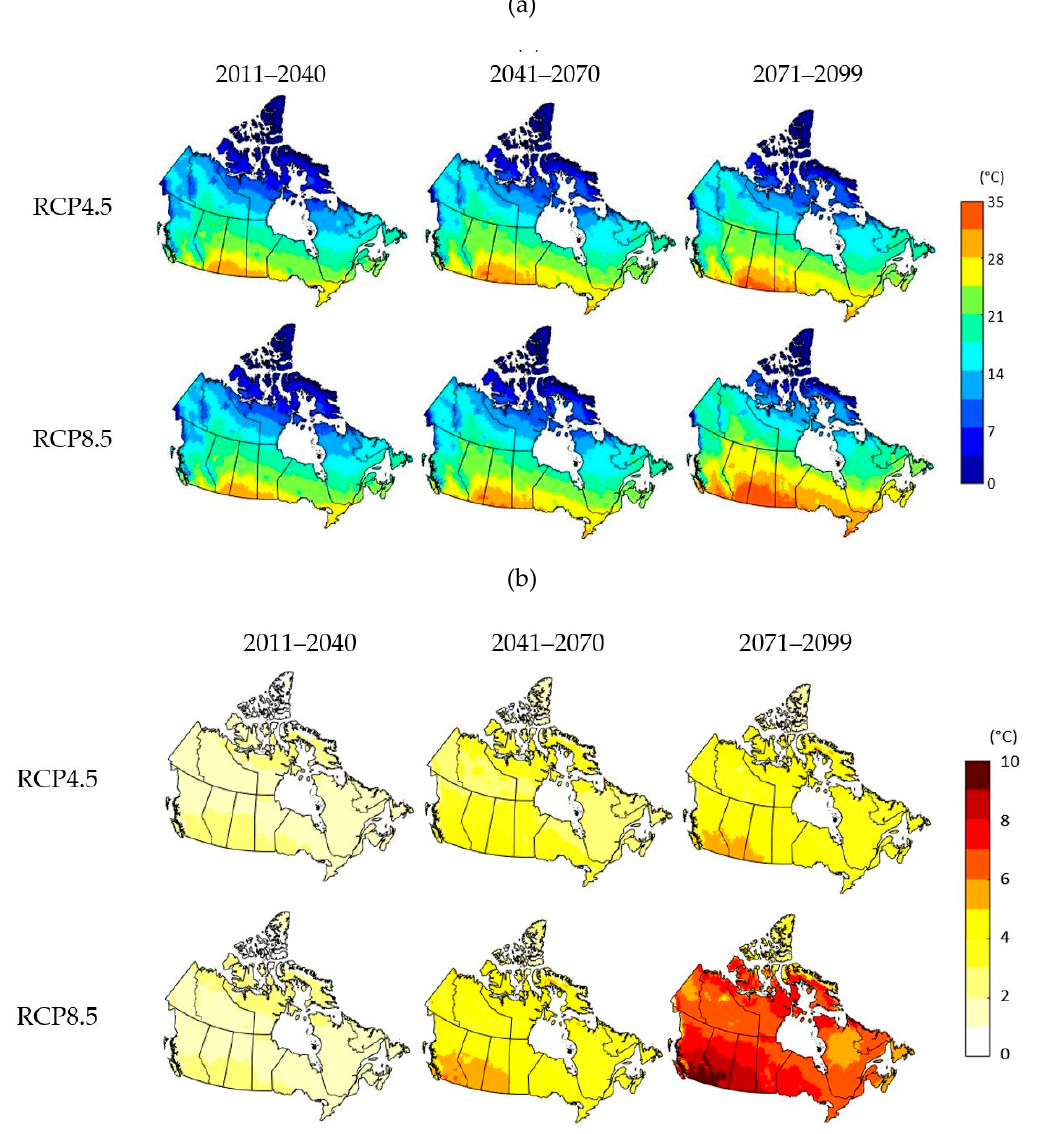
Figure 5. (a) Mean daily maximum temperature for summer (JJA) for the 2011–2040, 2041–2070